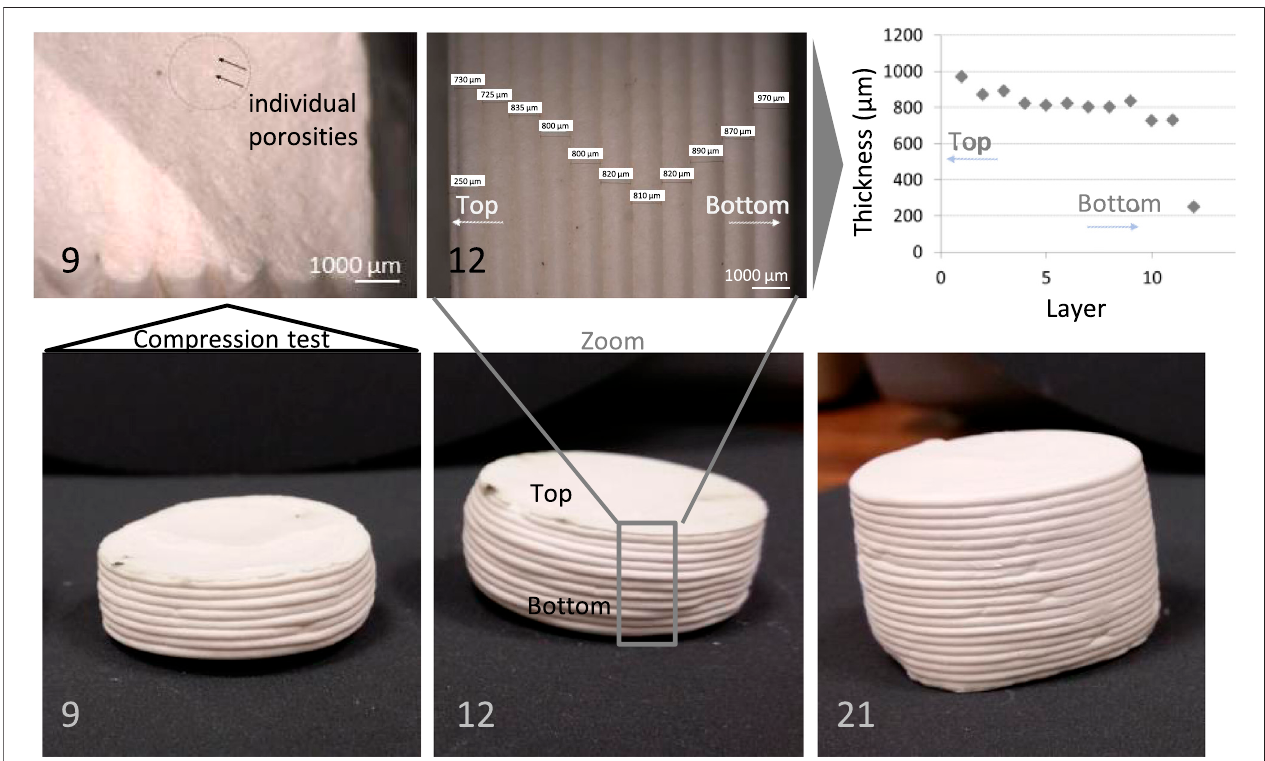
FIGURE6| Printed pawns after sintering, fi rstcampaignwithStep2: annealingat 500 ° C,1 h. Theillustrations (9,12, and21 mm) showthedimensionalstability of the parts. Right side: facies of rupture after compression test (1 mm/min 25% deformation, T 23 ° C) on 9 mm pawn. Medium side: size of the inter- fi lament on 12 mm pawn. Printed-layer thickness of 1 mm. Cylinders of 20 mm in